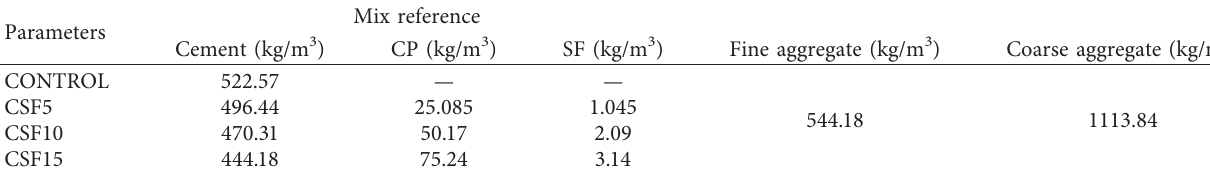
Table 3: Mix proportion: ternary (cement+SF+ CP).